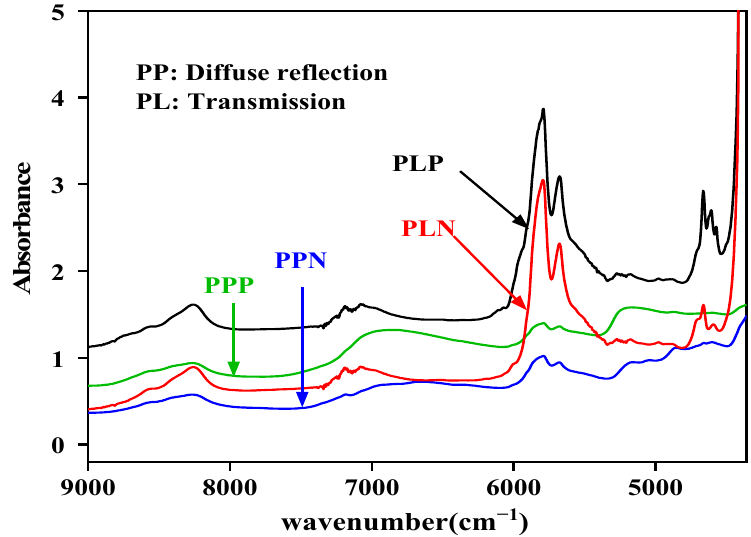
Figure 3. Average FT-NIR spectra collected by the diffuse reflection and transmission modules.